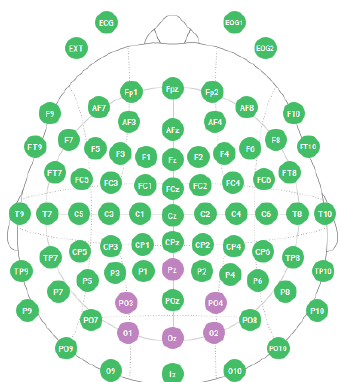
Figure 1. Disposition of the 6 electrodes used according to the international 10–20 system for electrode placement.